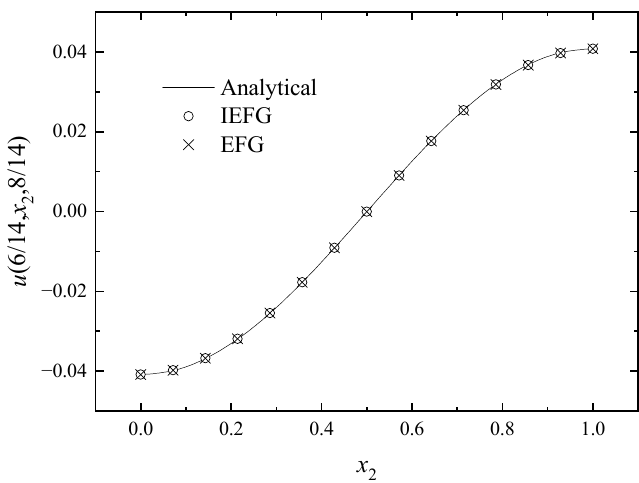
Figure 17. The comparison of numerical and exact solutions along x 2 -axis.